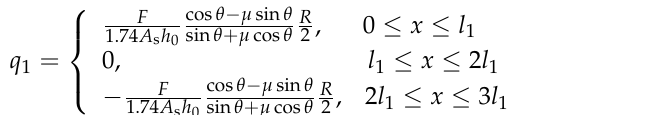
After load-induced cracking of RC beams: